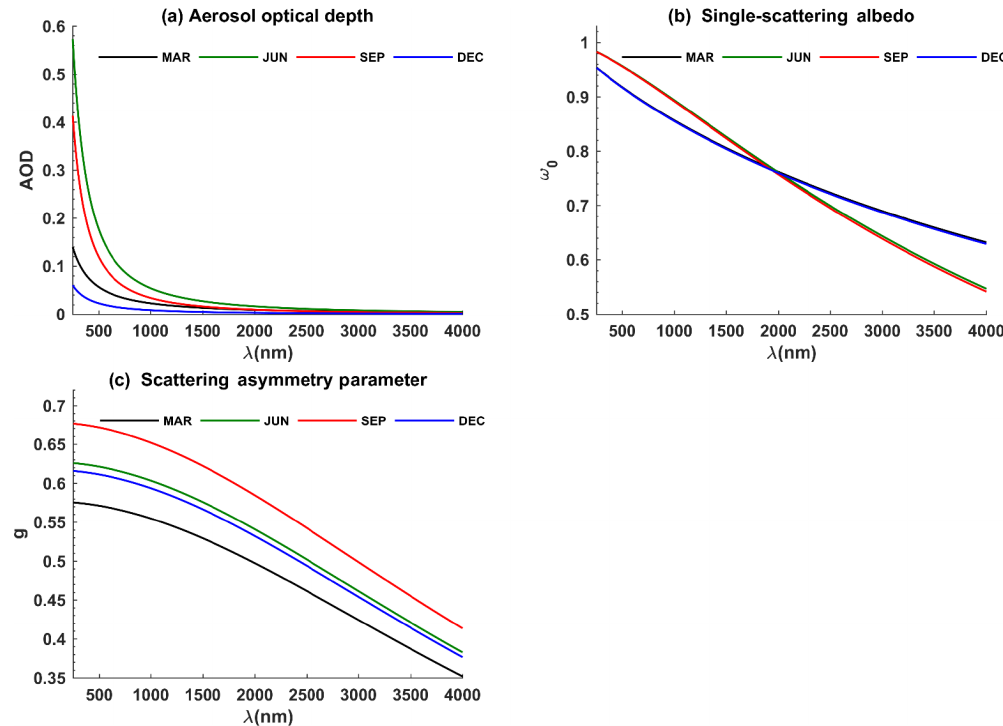
Figure 2. Wavelength dependence of AOD, ω 0 , and g , calculated using Eqs. (1)–(3), and base case aerosol optical properties for each season (Table 1). The MAR and DEC curves are nearly identical in (b) , as are the JUN and SEP curves in (b) , due to the use of nearly identical base case aerosol optical properties in generating the curves. Table 1. Base case values of aerosol optical properties, spectrally-averaged surface reflectance ( R ), and vegetation surface cover (SC) coefficients used by SBDART to calculate diurnally averaged DRE for the months MAR, JUN, SEP, and DEC. The vegetation SC coefficients produce the spectral reflectance curves in Fig. 3 and are the linear combinations SC = (snow, water, vegetation, sand) that best match monthly averaged spectral reflectance measured by MODIS. The base case aerosol optical properties are the monthly median values (Fig. 5). Property p i